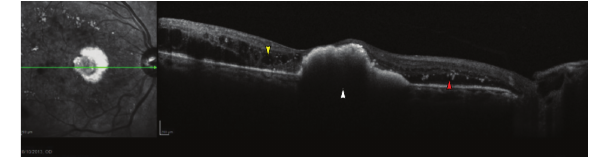
Figure 4: An OCT horizontal line scan of a woman with diabetes, with a juxtafoveal accumulation of hard exudates (white arrowhead) and substantial fluid at the level of outer plexiform layer (yellow arrowhead). Diffuse hyperreflective hard exsudates can also be seen (red arrowhead).